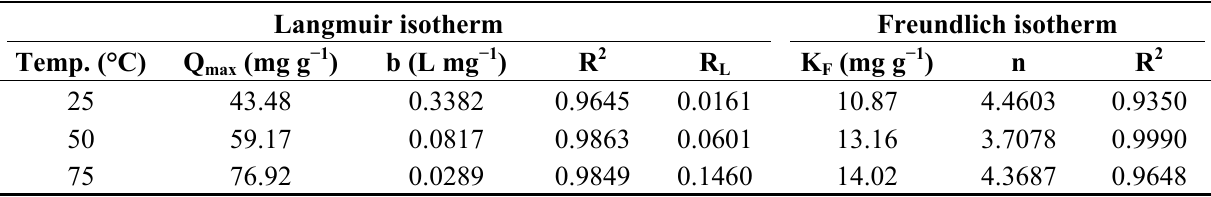
Table 1. Langmuir and Freundlich isotherm constants, maximum adsorption capacities, Q , correlation coefficients, and R 2 values for copper adsorption at various temperatures. max Langmuir isotherm Freundlich isotherm Temp. (°C)